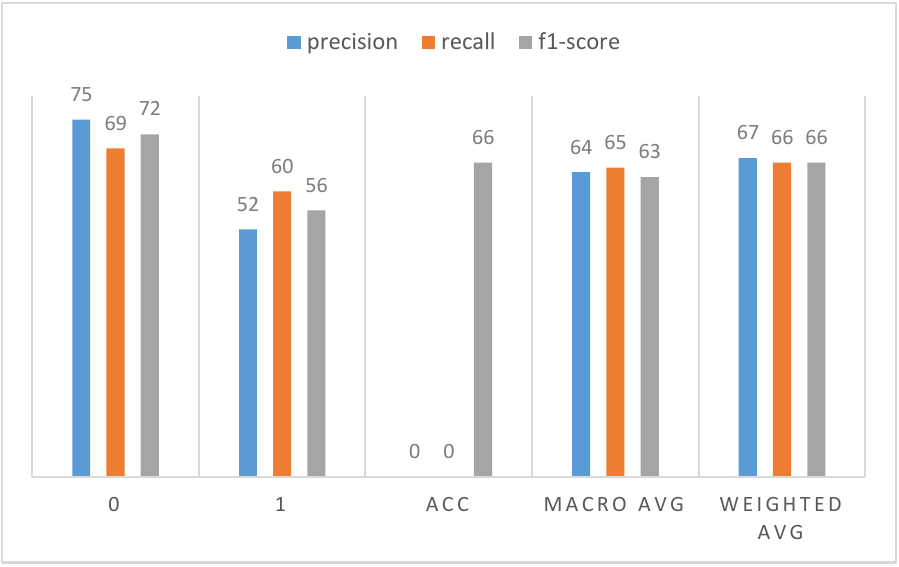
Figure 18. Summary of results for a testing dataset equal to 90% and training dataset of 10%.